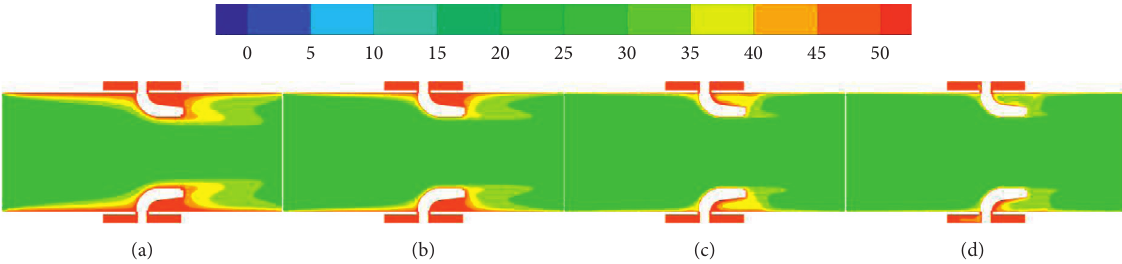
Figure 11: Temperature field distribution in fluid domain at 50 ° C. (a) 10m 3 /h. (b) 100m 3 /h. (c) 500m 3 /h. (d) 1000m 3